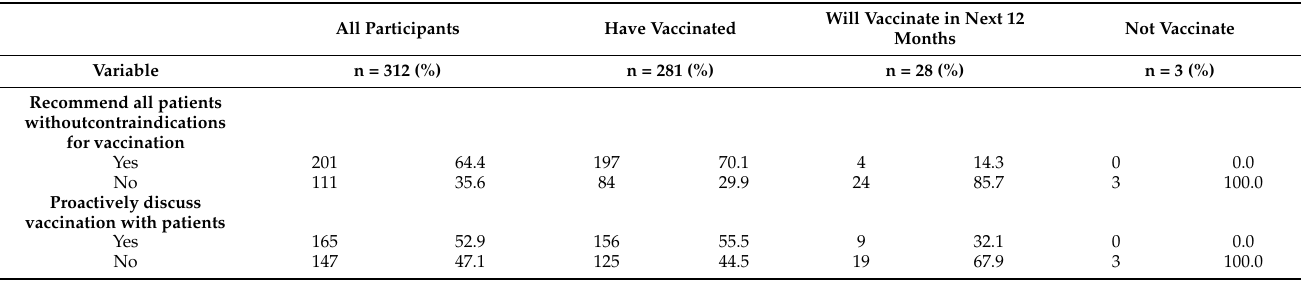
Table 2. Vaccination status of family doctors and their practice concerning recommendation and discussion with patients about COVID-19 vaccines (N = 312).